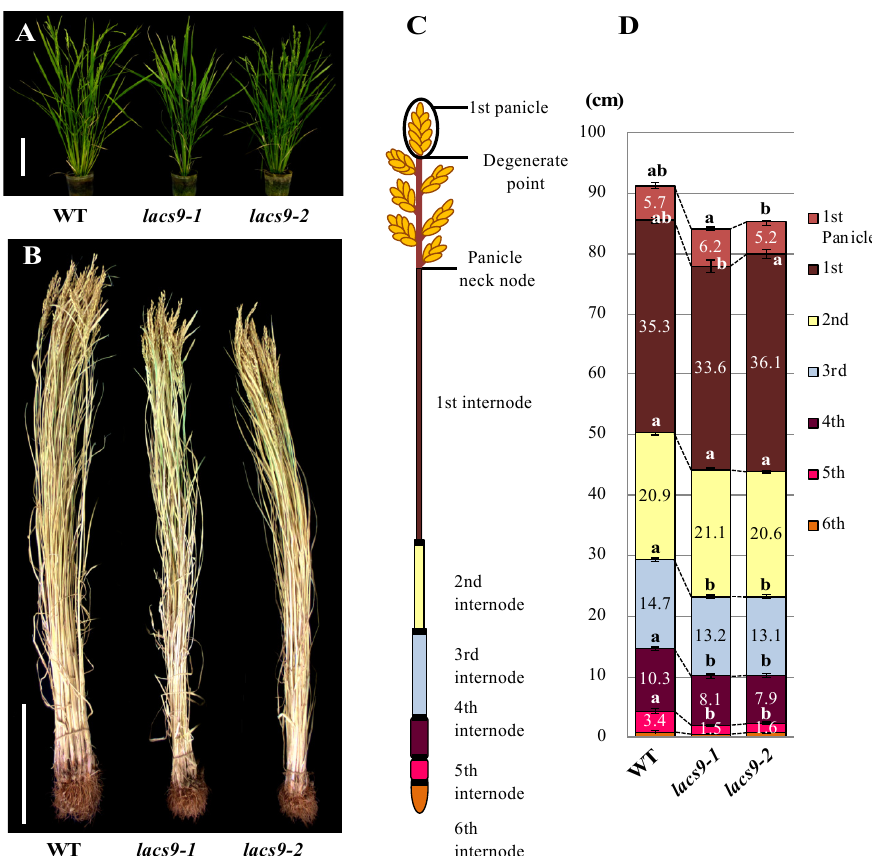
Figure 1. Phenotype of the wild type (WT) and lacs9 mutant lines ( lacs9-1 and lacs9-2 ) of rice. Panel ( A ) nine-week-old WT and lacs9 mutant lines, ( B ) growth performance of the WT and lacs9 mutant lines. Bars = 20 cm. ( C ) Schematic representation of measurable internode pattern in rice until the panicle neck node and ( D ) internode length of WT and both lacs9 mutants ( n = 60). Values represent the mean ± standard deviation (SD). Within WT and each mutant lines with the same letter do not di ff er significantly ( P ≤